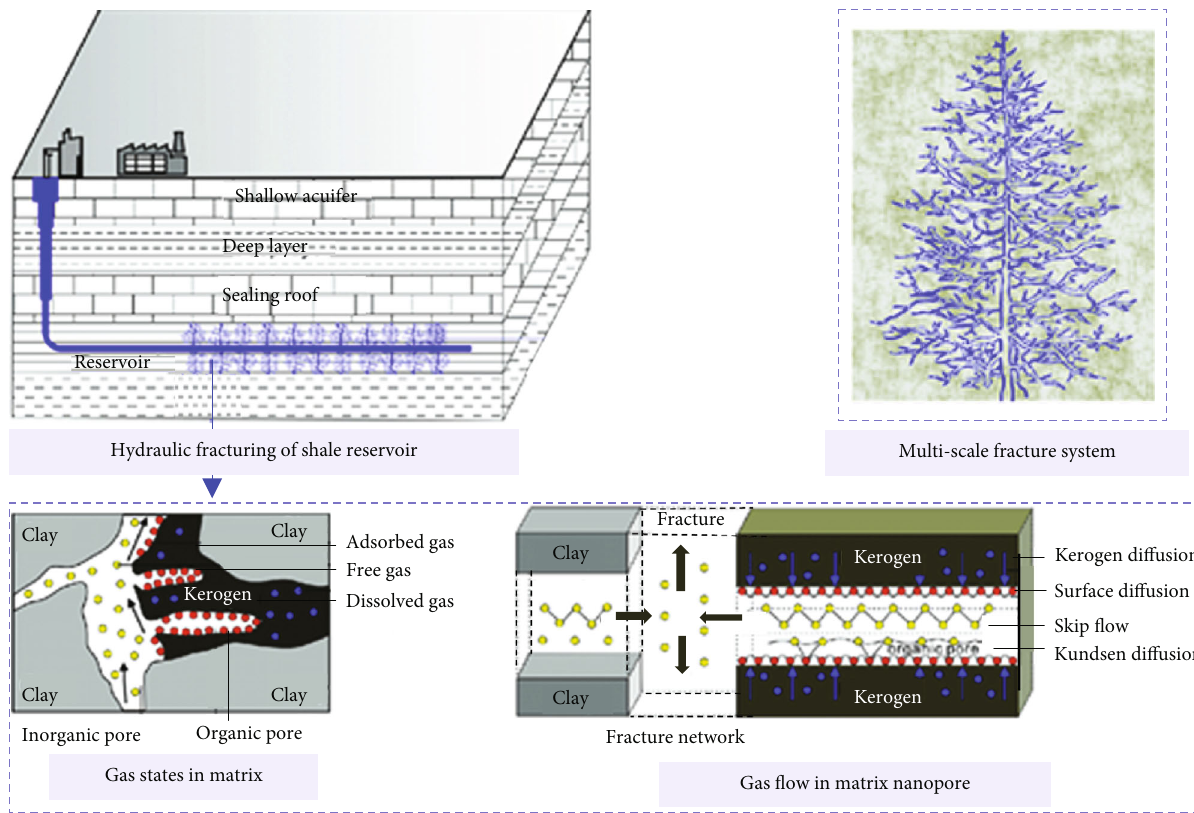
Figure 1: Complex fl ow behavior in shale gas reservoirs